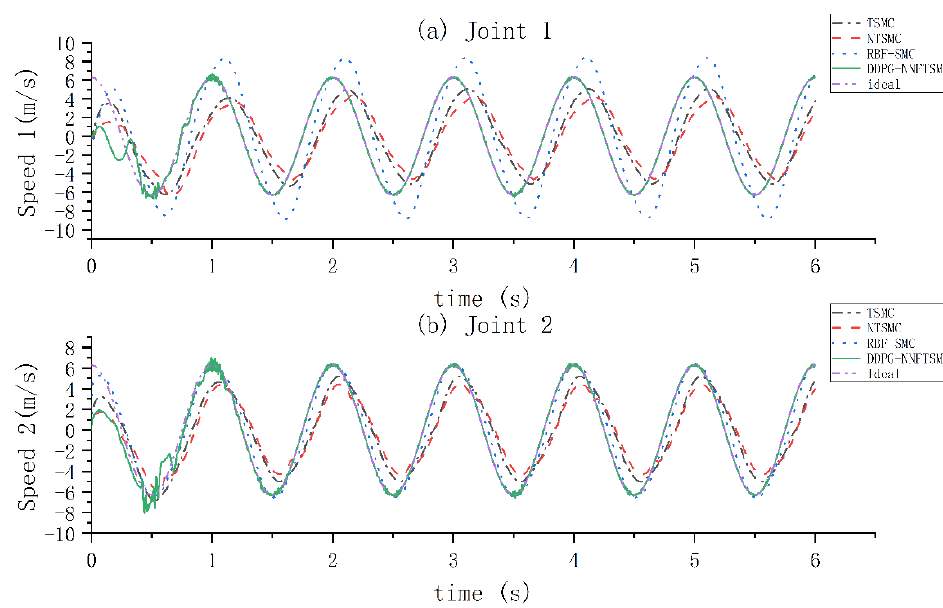
Figure 5. Trajectory tracking speeds.